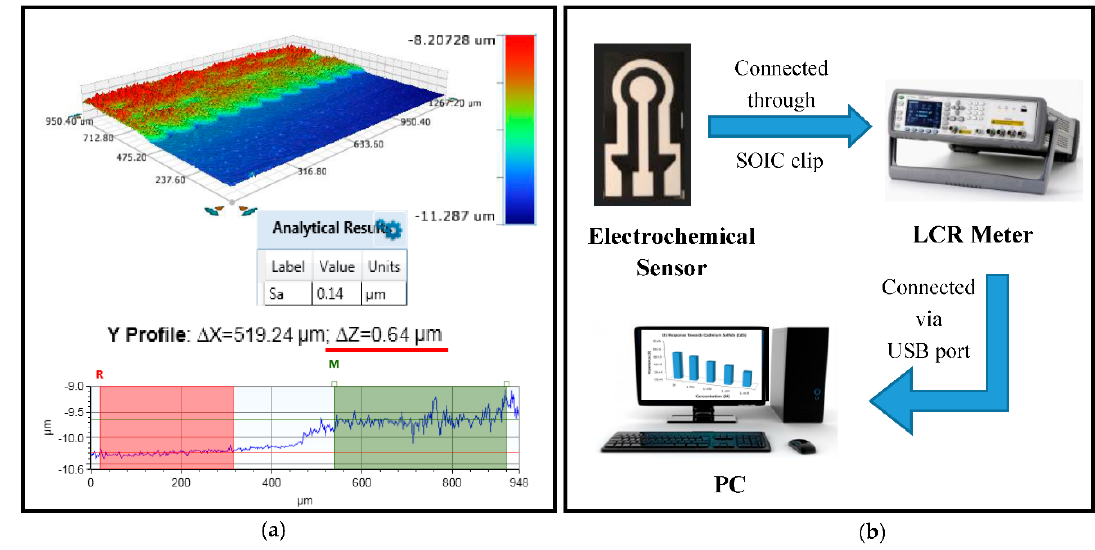
Figure 2. ( a ) 3D Profilometry scan of the printed gravure printed Ag layer on PET illustrating a total thickness ( Δ Z) of 0.64 µm and roughness (Sa) of 0.14 µm; ( b ) Experiment